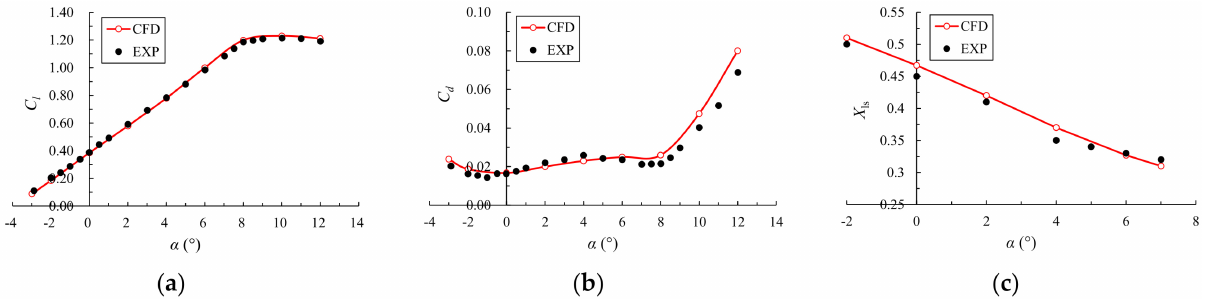
Figure 2. CFD and experimental results for Eppler 387 at Re = 1.0 × 10 5 : ( a ) Lift coefficient vs. angle of attack; ( b ) Drag coefficient vs. angle of attack; ( c ) Laminar separation location vs. angle of